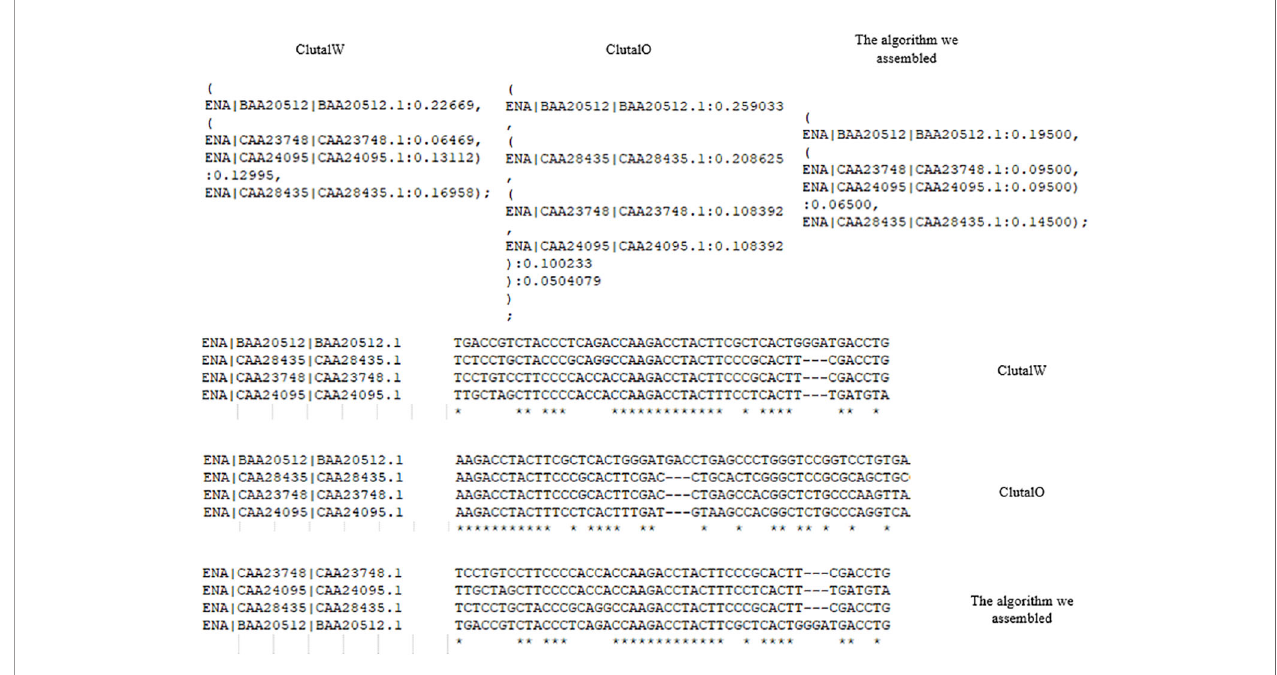
FIGURE 7 | Alignment